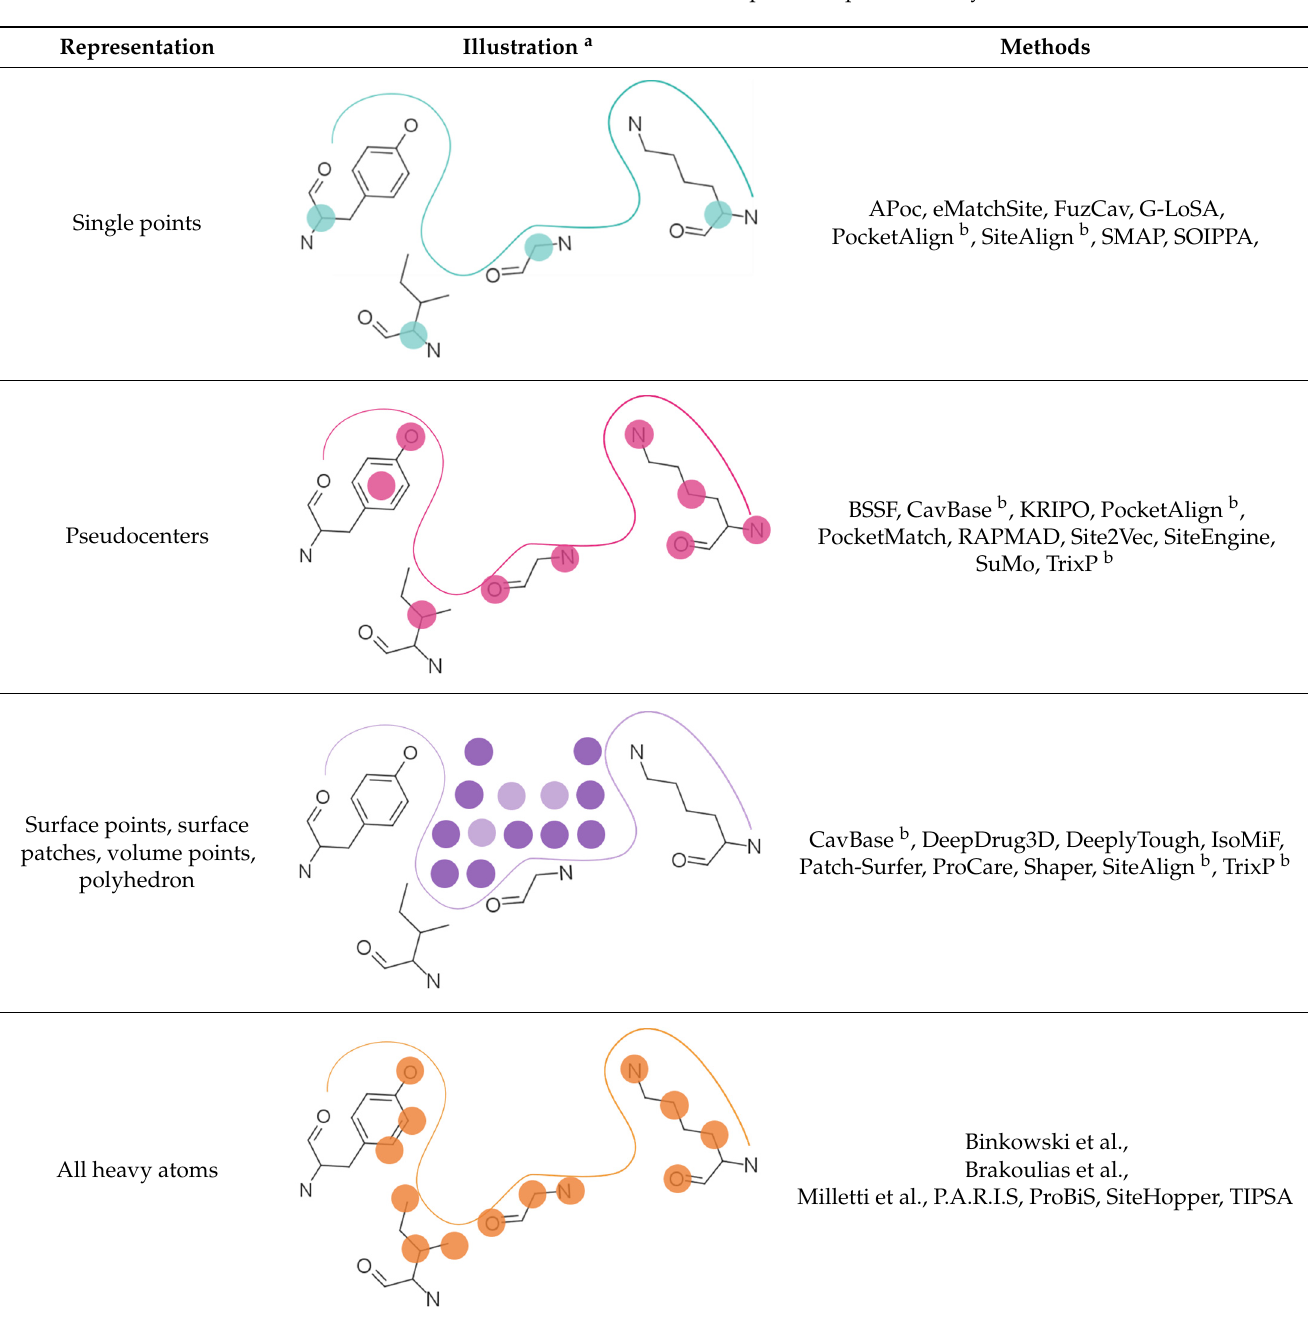
Table 3. Discretization of the residues to represent a protein cavity.